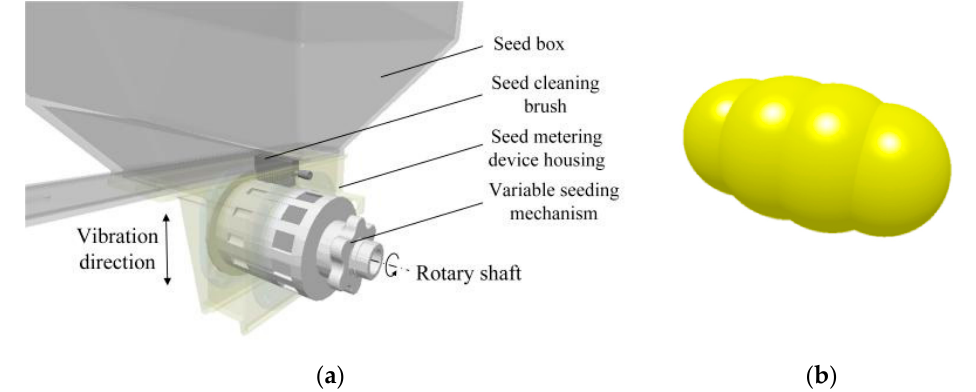
Figure 5. Simulation model. ( a ) Seed metering device model; ( b ) Wheat seed model.